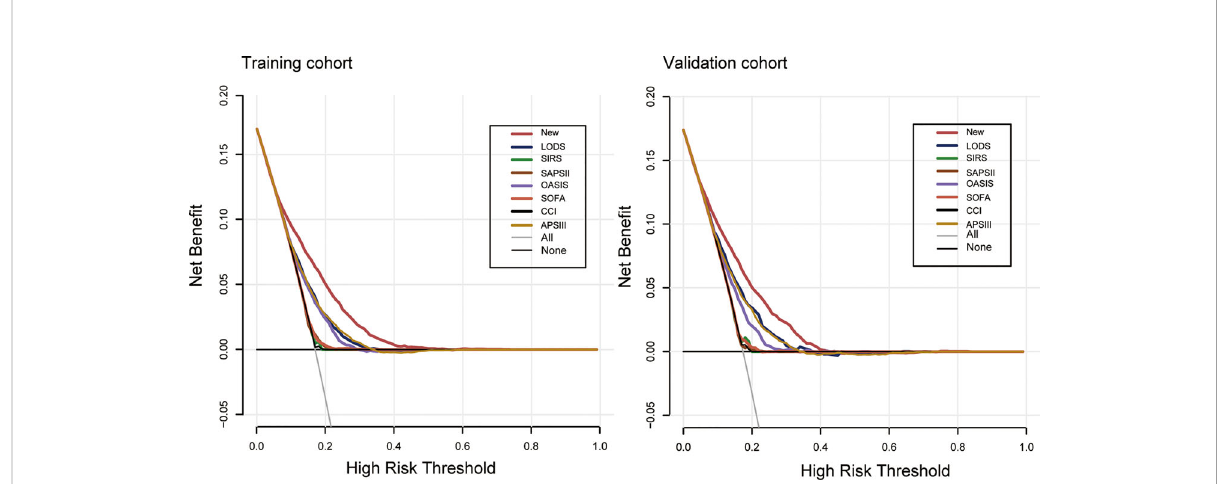
FIGURE 7 Decision curve analysis comparing the clinical utility of our new model (red line) with that of the other score systems. The clinical utility of all models is compared by measuring the net bene fi t (y-axis) for a range of threshold probability (x-axis). The black line represents the assumption that no patient has ICU-acquired infection. The gray line suggests that all patients have ICU-acquired infection. At the full range of displayed probabilities (0 – 0.2), the curve based on the integrated model (red) showed maximized bene fi t compared to other